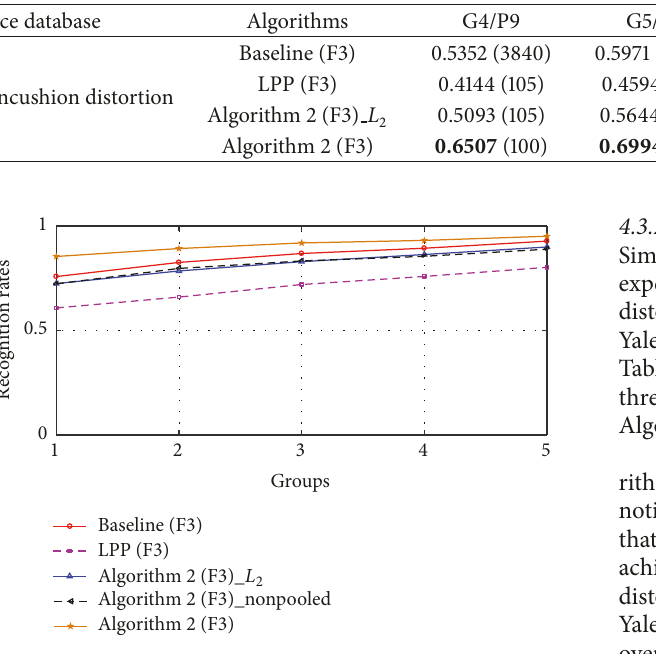
Figure 11: The recognition rates on subAR face database over “F3”